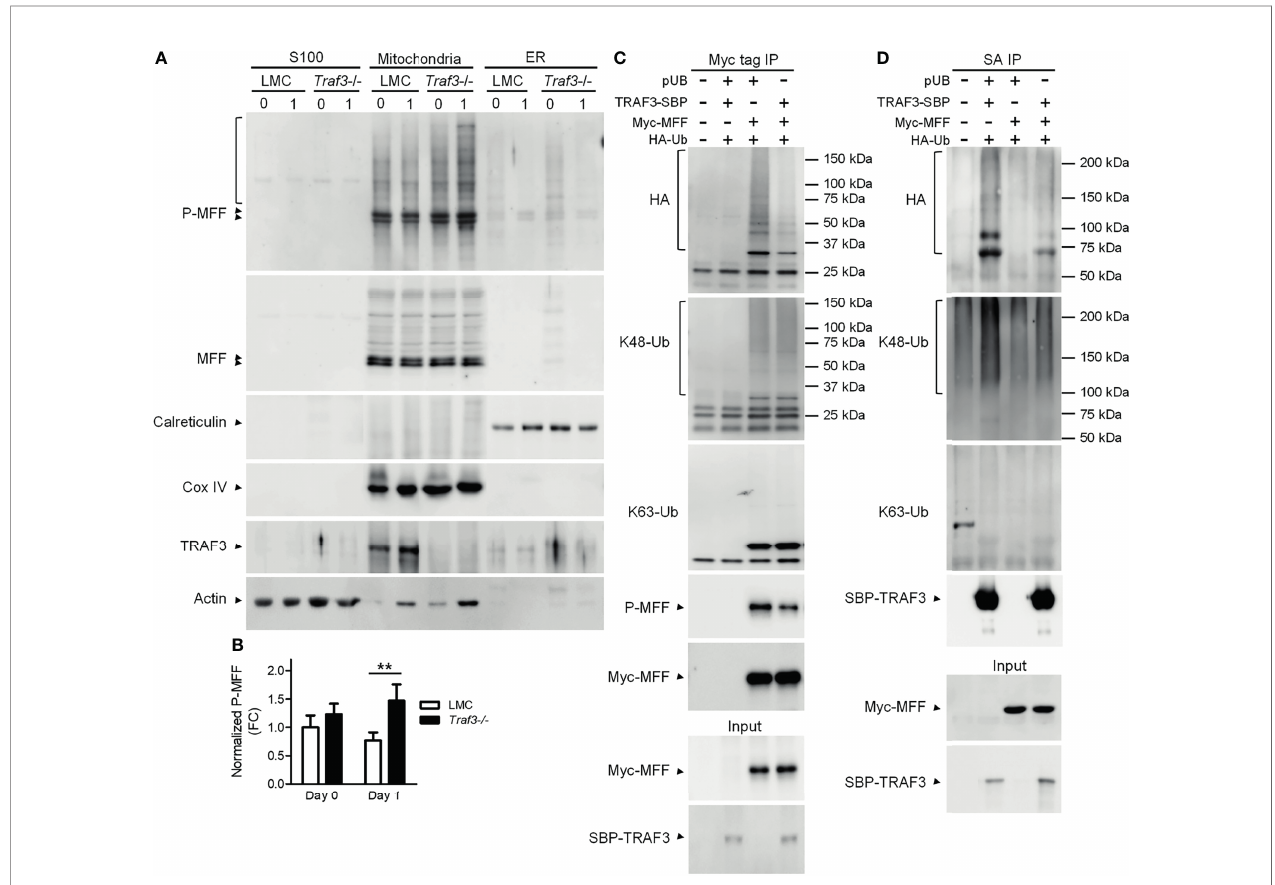
FIGURE 6 | The TRAF3-MFF interaction affected the modi fi cations of MFF and TRAF3. (A, B) Phosphorylation of MFF in resting B cells. Splenic B cells were puri fi ed from gender-matched, young adult (8-12-week-old) naïve LMC or B- Traf3 -/- mice. Puri fi ed cells were analyzed directly (Day 0) or at day 1 after ex vivo culture. S100 (cytosolic), mitochondrial and ER proteins were biochemically fractionated and analyzed by immunoblotting. Proteins in each fraction were immunoblotted for phosphorylated MFF (P-MFF), total MFF, Calreticulin (an ER protein) and COX IV (a mitochondrial protein), followed by TRAF3 and actin. (B) Graphical results of the normalized P-MFF in the mitochondrial fraction. The phosphorylated and total MFF bands on the immunoblots in (A) were quantitated using a low-light imaging system. The intensity of P-MFF bands in each lane of the mitochondrial fraction was normalized to that of the corresponding total MFF bands. Fold of change of the normalized P-MFF relative to that detected for LMC B cells at Day 0 was shown in the graph (mean ± SD, n = 3). ** p < 0.01 by t test. (C, D) Ubiquitination of MFF and TRAF3 was affected by the MFF-TRAF3 interaction in 293T cells. Cells were co-transfected with lentiviral expression vectors of HA- tagged ubiquitin (LPA-HA-Ub) and Myc-tagged MFF (pUB-Myc-MFF), SBP-tagged TRAF3 (pUB-TRAF3-SBP-6xHis) or an empty vector pUB-Thy1.1. Transfected cells were harvested at day 2 post transfection. Total cellular proteins were immunoprecipitated with Anti-c-Myc Tag (9E10) Af fi nity Gel (C) or Streptavidin-Sepharose beads (D) . Immunoprecipitates [Myc tag IP in (C) or SA IP in (D) ] were immunoblotted for the HA tag, K48-Ub and K63-Ub to detect the ubiquitination, K48- or K63-linked polyubiquitination of MFF (C) and TRAF3 (D) , respectively. Phosphorylated MFF (P-MFF) was also analyzed in the Myc tag IP (C) . Immunoblotting of Myc- MFF and SBP-TRAF3 was performed with both the immunoprecipitates and input lysates (bottom panels). Immunoblots shown are representative of 3